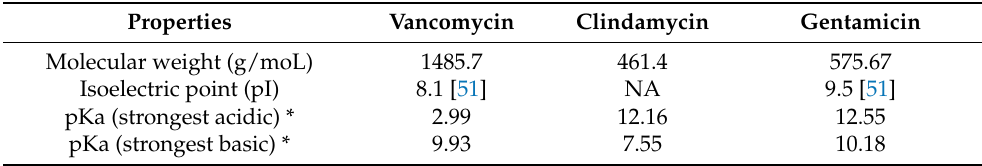
Table 1. Summary of the different properties of antibiotics used in this study. (NA = not